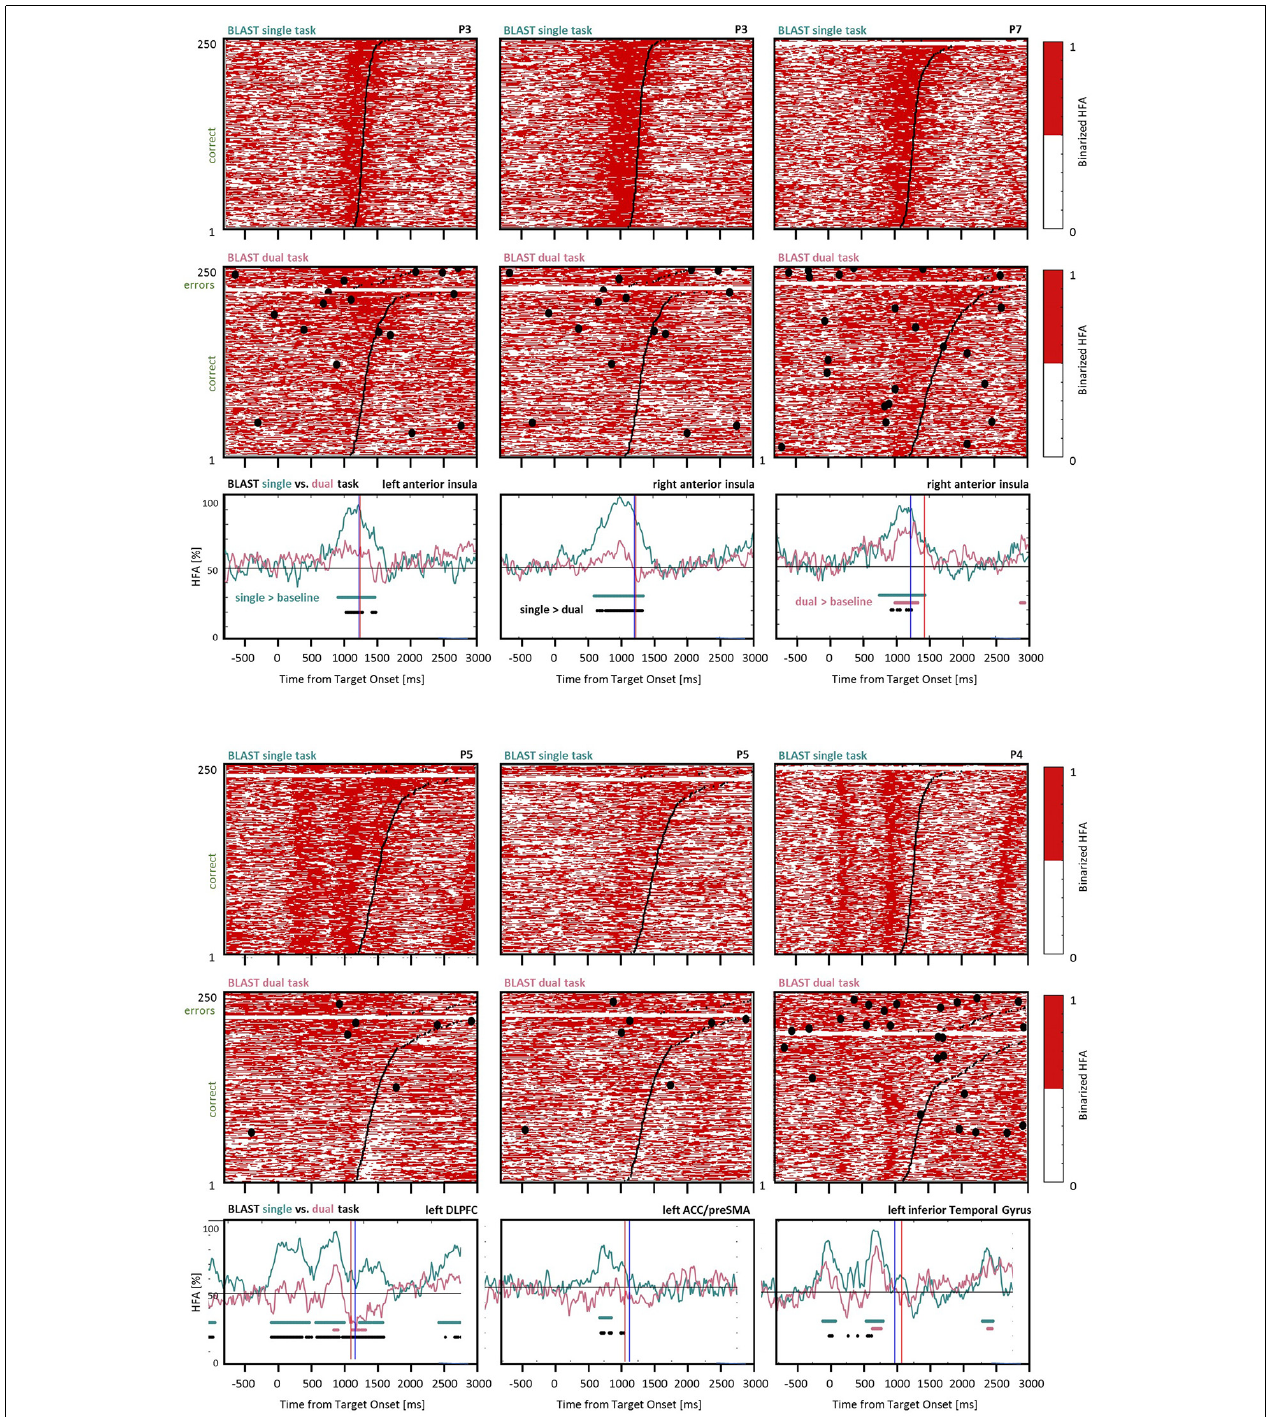
FIGURE 12 | Interference control in the executive network and the language network. Comparison of BLAST-related activity in the ST and DT conditions for six sites (five of them supporting executive control in the anterior insula, DLPFC, and ACC/preSMA, the last one supporting visual processes in the inferior temporal gyrus). For each site, BLAST-related neural activity is represented as a binarized matrix for the ST (top) and DT (middle) conditions. The curves at the bottom correspond to the average of those matrixes for the M fastest correct trials, where M equals half the number of correct trials in the DT condition. Horizontal lines indicate samples with a significant difference between the DT and ST curves (black), or a significant increase relative to the [ − 200:0 ms] pre-Target baseline, for the ST and DT conditions respectively (in green and red; Kruskal-Wallis test, with a False-Discovery Rate correction for multiple comparisons). From left to right and top to bottom, iEEG sites and [Patients id] are: X’9 [P3]; X7 [P3]; E4 [P7]; K’10 [P5]; Z’2 [P5]; E’7 [P4].